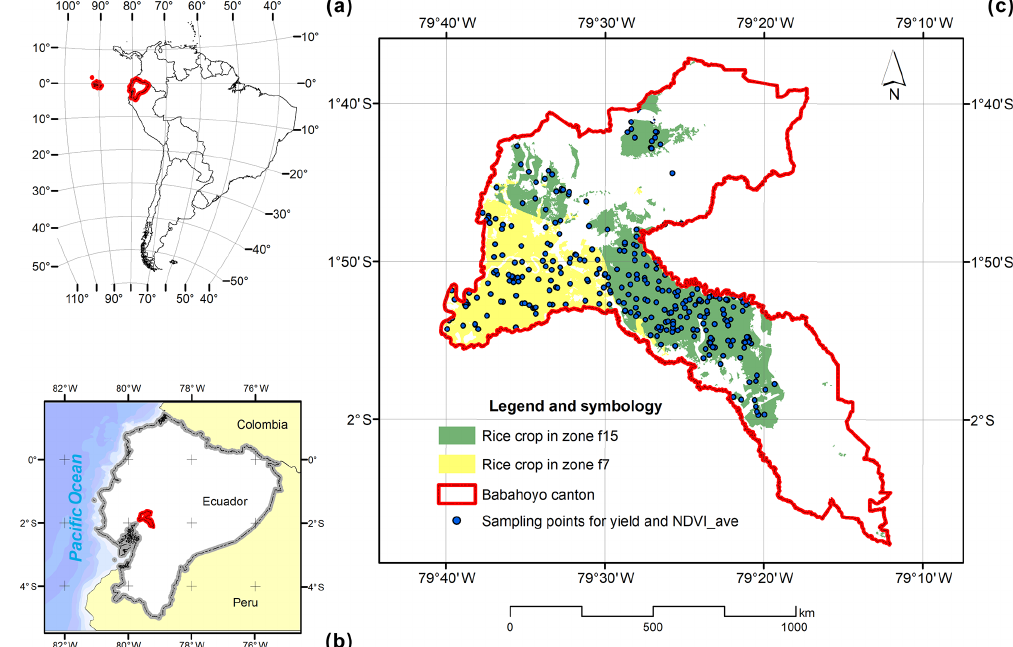
Figure 1. (a) Location of Ecuador in South America, (b) location of Babahoyo in Ecuador, and (c) agro-ecological homogeneous zones f7 and f15 over rice cultivation area with yield observations in